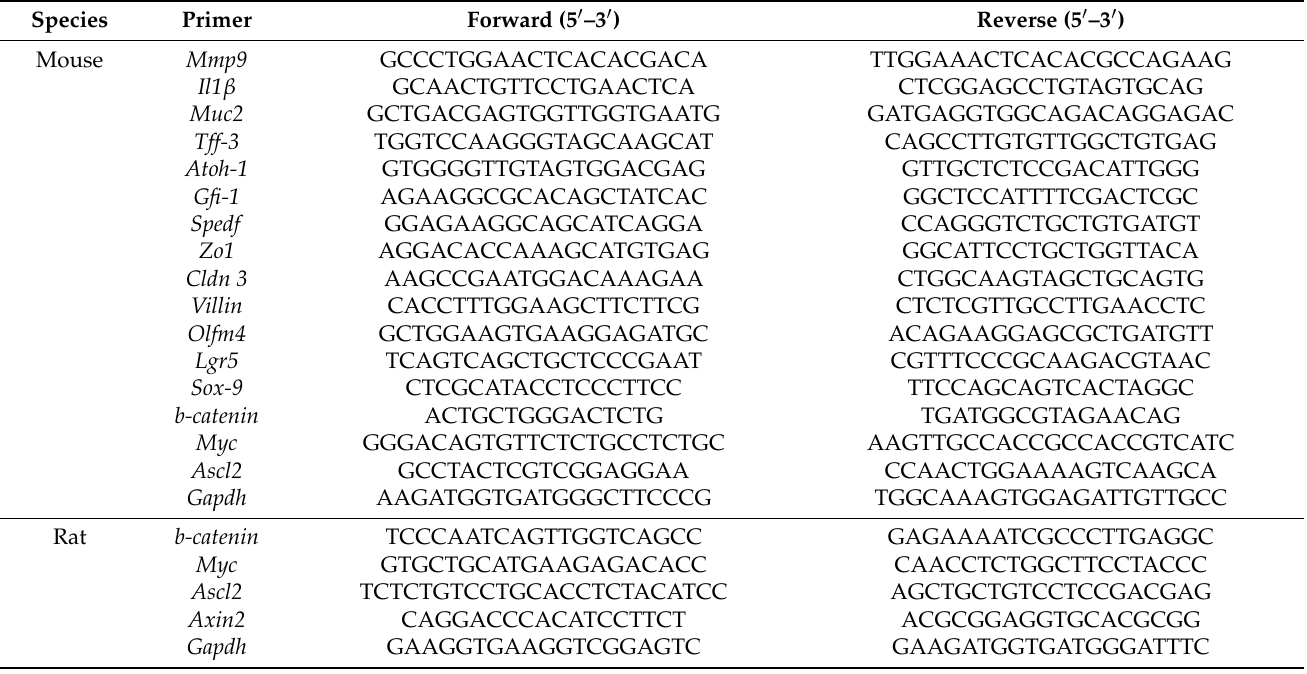
Table 1. Primer sequences used in